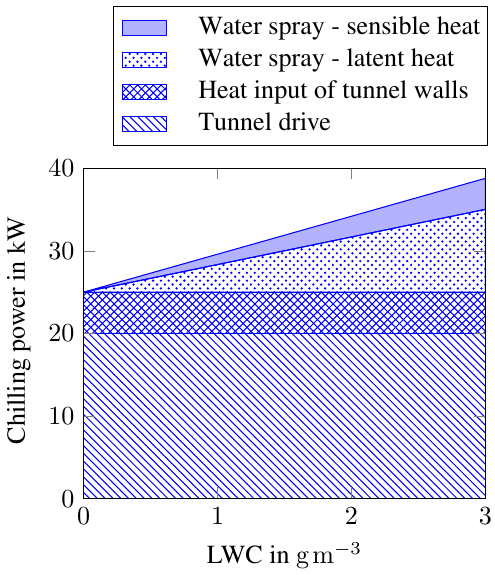
Figure 5. Required chilling power decomposition as a function of the liquid water content for typical operational conditions of the Braunschweig Icing Wind